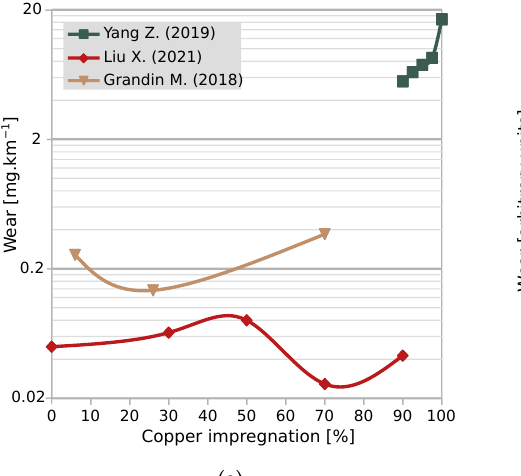
Figure 7. ( a ) Wear measures depending on copper impregnation in graphite material from three authors [6,31,47]. ( b ) Typical dependence of wear depending on the copper content in graphite: (1) full graphite material has a high contact electrical resistance; (2) low copper content weakens the material structure; (3) formation of a copper matrix that strengthens the material; (4) optimal point; (5) high copper content weakens the material due to oxidation sensitivity; (6) without the self-lubrication of the graphite, the wear of full copper material is